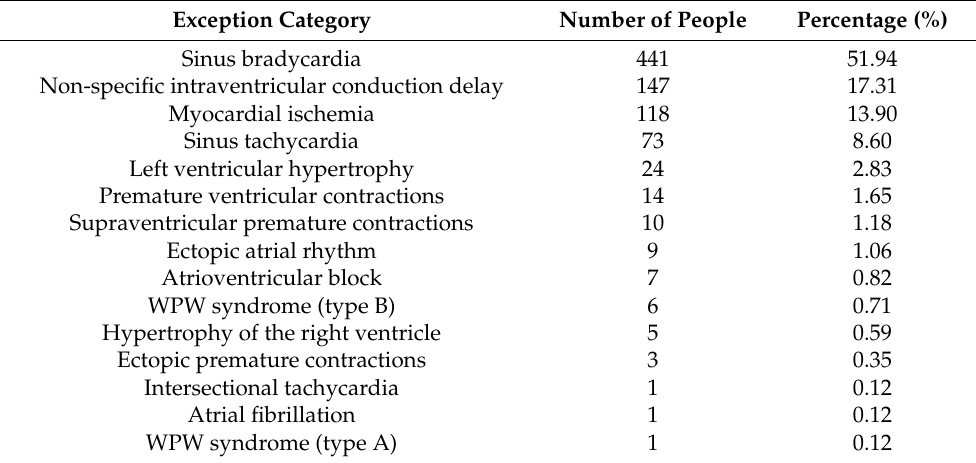
Table 2. Detection of abnormal ECG in coal workers.